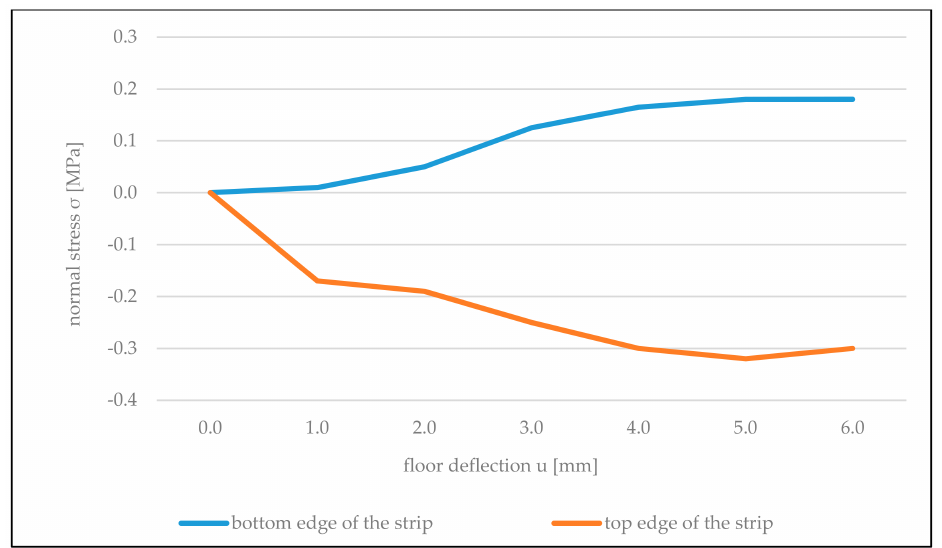
Figure 17. Graphs of changes in normal stresses on edges of the wall strip above the opening in the wall not connected with cross walls, depending on the floor deflection u